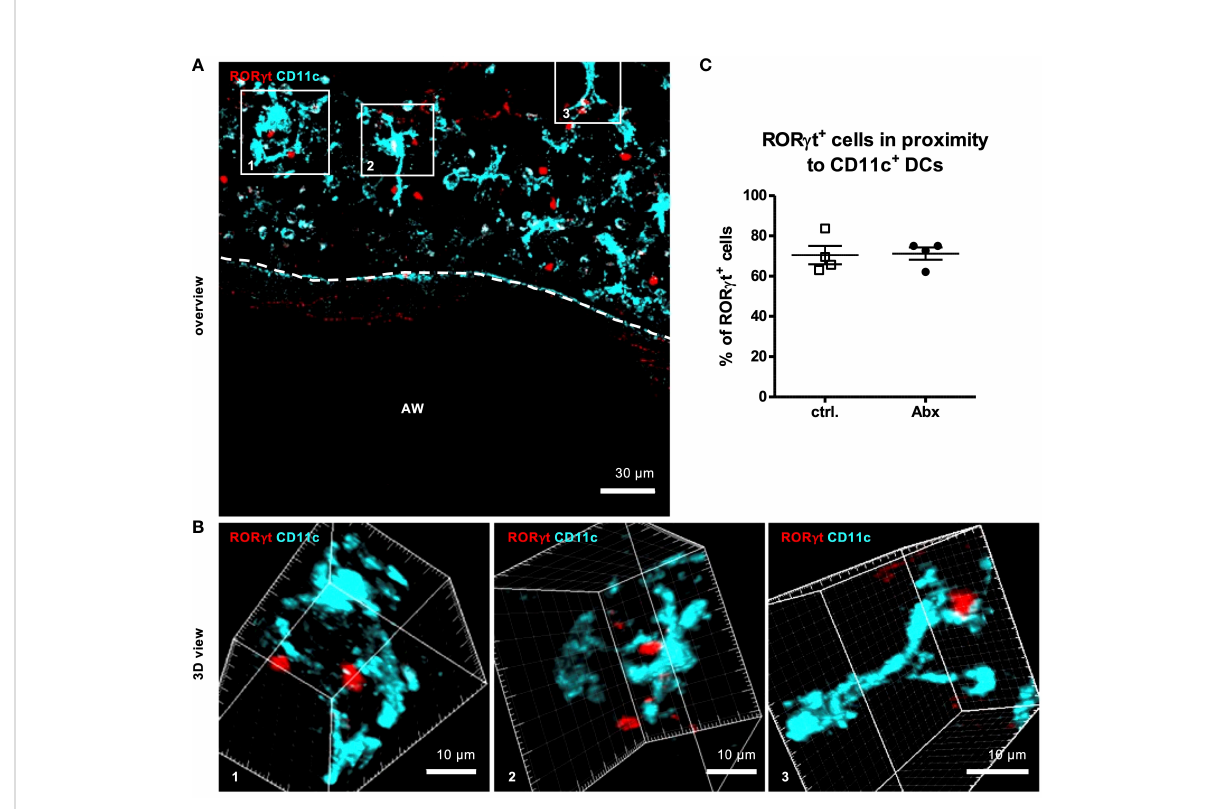
FIGURE 6 Prenatal antibiotic exposure of dams does not in fl uence the frequency of contacts between ROR g t + cells and CD11c + cells in situ . C57BL/6 mice were treated with vancomycin, ampicillin and gentamycin (all at 1.0 mg/mL)(Abx) from prenatal day 15 until birth. Mice treated with sucralose served as controls (ctrl.). At 6-8 weeks, offspring C57BL/6 mice were immunized i.p. with 10 µg/100 µL of HDM. Seven days later mice received an additional i.p. injection of HDM. After 14 and 21 days mice were treated with 100 µg/40 µL HDM i.t. 72 h after the last treatment 300 µm lung sections of agarose fi lled lungs were prepared. Staining with anti-ROR g t (red) and anti-CD11c (turquoise) allowed evaluation of interactions between ROR g t + cells and CD11c + DCs. Stained slices were evaluated with laser scanning confocal microscopy generating Z-Stacks. (A) A representative overview of a large airway is shown. Enlarged 3D views (B) of framed areas allowed 3D analysis of contact rates of ROR g t + cells with CD11c + DCs (C) . Abbreviations: AW, airway. Data are representative of at least four independent experiments. Scatter plot with mean ± SEM. n = 4 mice. Each dot represents the Z-stack of one